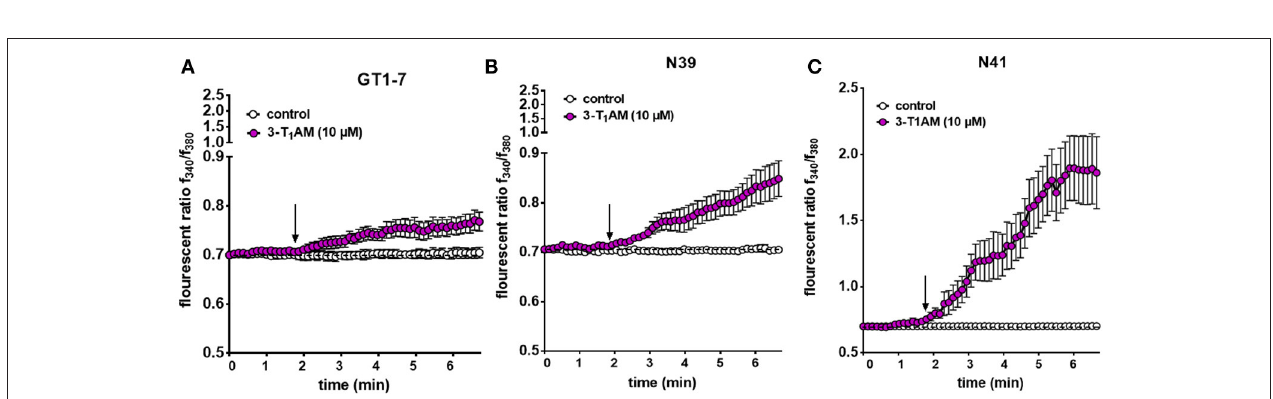
FIGURE 5 | 3-T 1 AM induces Ca 2 + influx in GT1-7, N39 and N41 cell lines. Changes in cytosolic free Ca 2 + are depicted as the ratio of the fluorescence induced by the excitation wavelength at 340 and 380nm. 10 µ M 3-T 1 AM induces an increase on intracellular Ca 2 + concentration in (A) GT1-7 ( n = 10), (B) N39 ( n = 15) and (C) N41 ( n = 15) cells. Notably, 10 µ M 3-T 1 AM induces a significantly larger increase in intracellular Ca 2 + in N41 cell line. Without compound application, no changes in Ca 2 + influx could be observed ( n = 10). Compounds were added to cells at the time points indicated by the arrow and n indicates number of the single